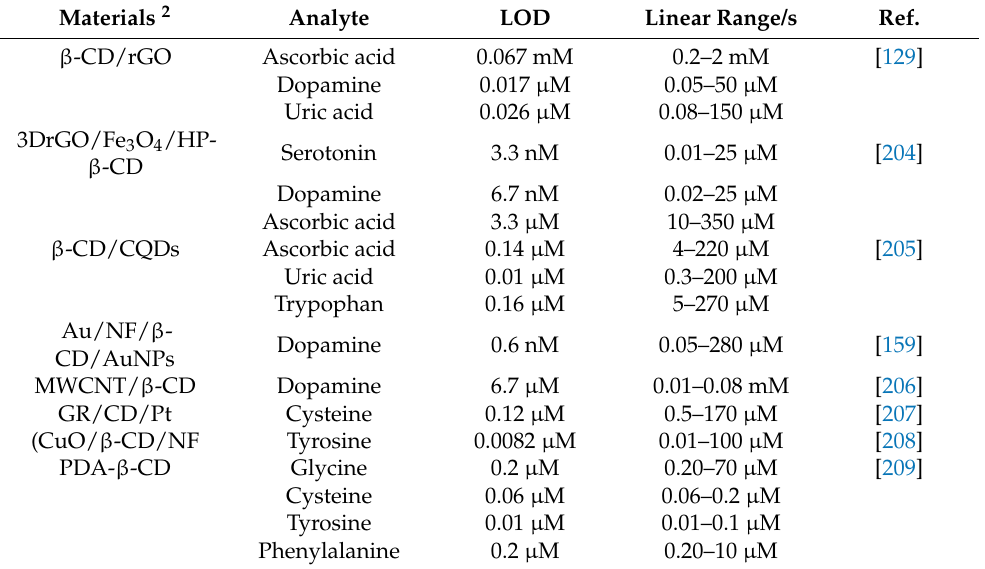
Table 3. Summary of some of the CD-based sensors used in the electrochemical detection of essential